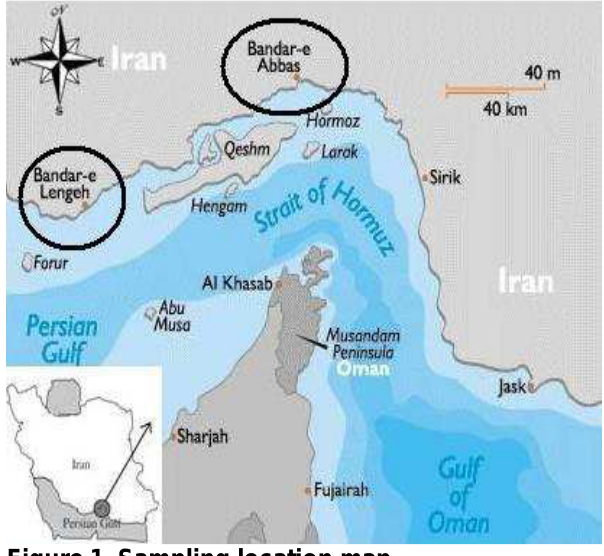
Figure 1. Sampling location